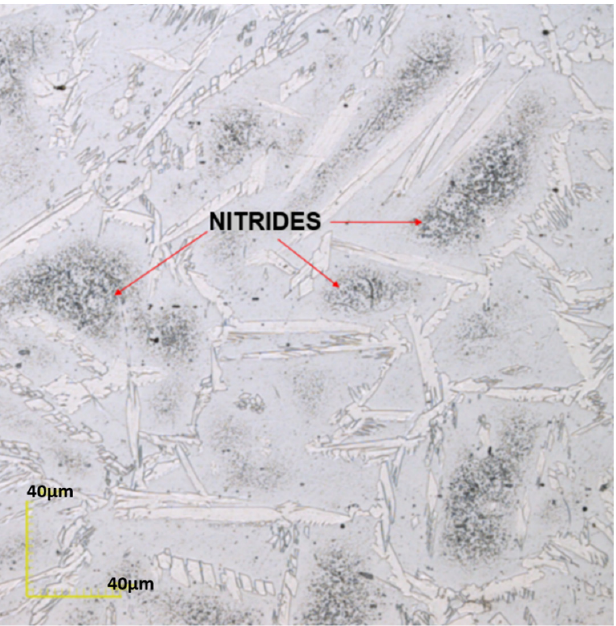
Figure 4. Representative microstructure found in the FZ. Electrolytic etching with 10% oxalic acid.